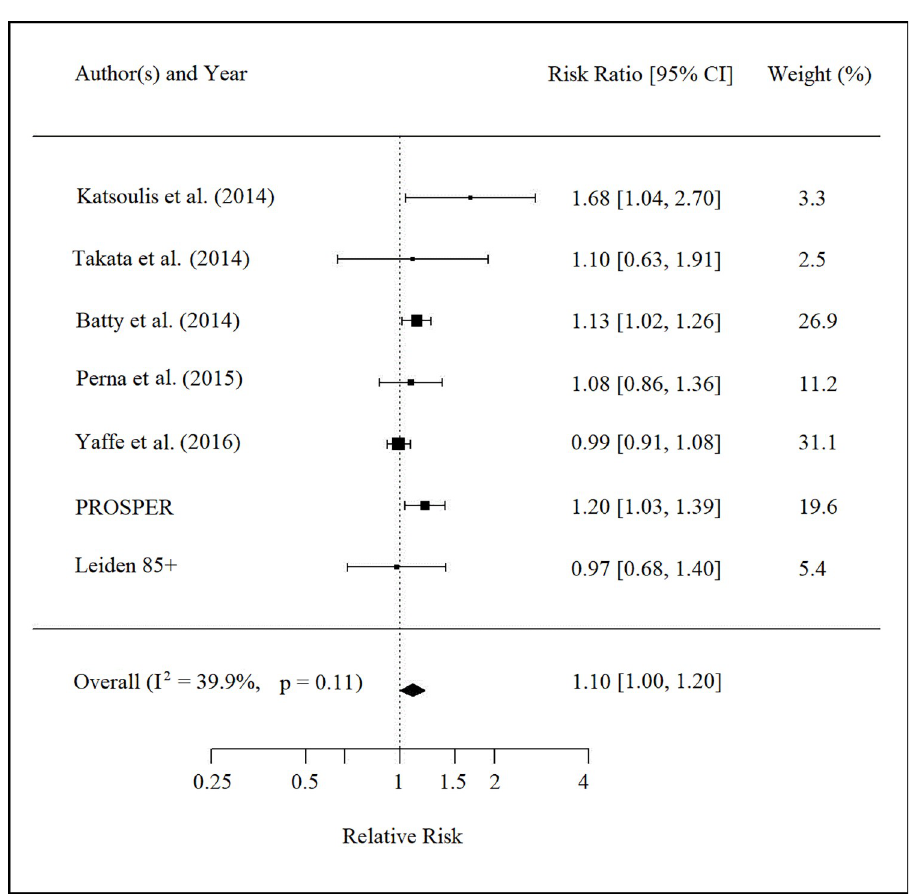
Fig 2. The relative risk of cancer death per standard deviation lower performance in cognitive